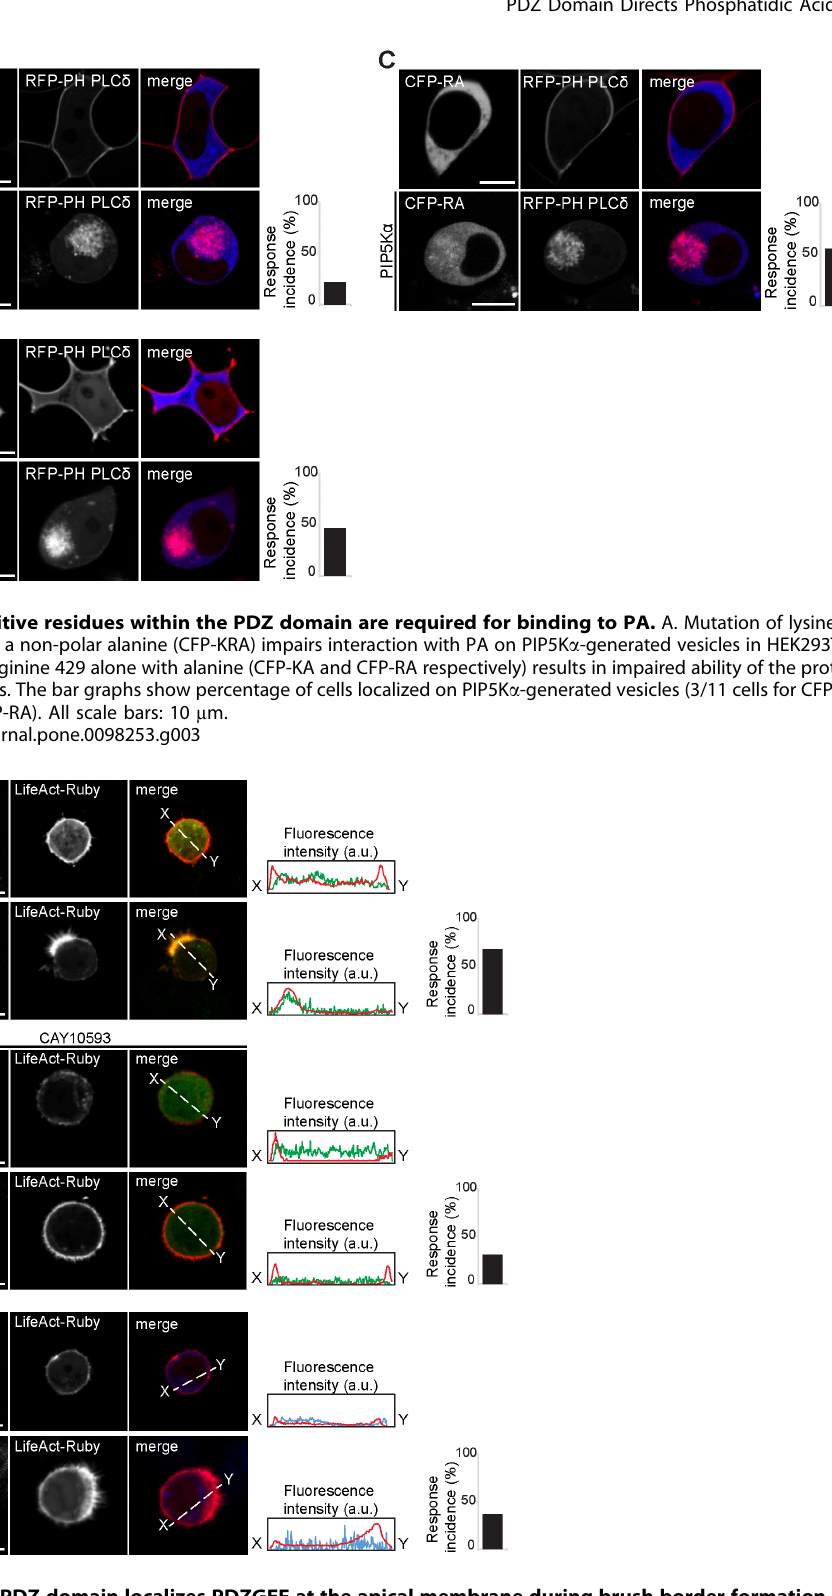
Figure 4. The PDZ domain localizes PDZGEF at the apical membrane during brush border formation via electrostatic interactions. A. Live-cell imaging of Ls174T-W4 cells transfected with YFP-PDZ and the actin binding probe LifeAct-Ruby with and without stimulation with doxycycline. B. Ls174T-W4 cells treated with the PLD1 inhibitor CAY10593 do not show accumulation of YFP-PDZ to the brush border of doxycycline- stimulated cells. C. The double mutant CFP- KRA is not able to localize at the brush border of Ls174T-W4 cells after doxycycline treatment. The profiles represent the fluorescence intensity across the cell as indicated by the dotted line. The bar graphs show the percentage of cells showing brush border localization of the protein following doxycycline treatment (8/12 cells for YFP-PDZ, 3/10 cells for YFP-PDZ in presence of CAY10593 and 4/11 cells for CFP-KRA). All scale bars: 10 m m. doi:10.1371/journal.pone.0098253.g004 PLOS ONE |